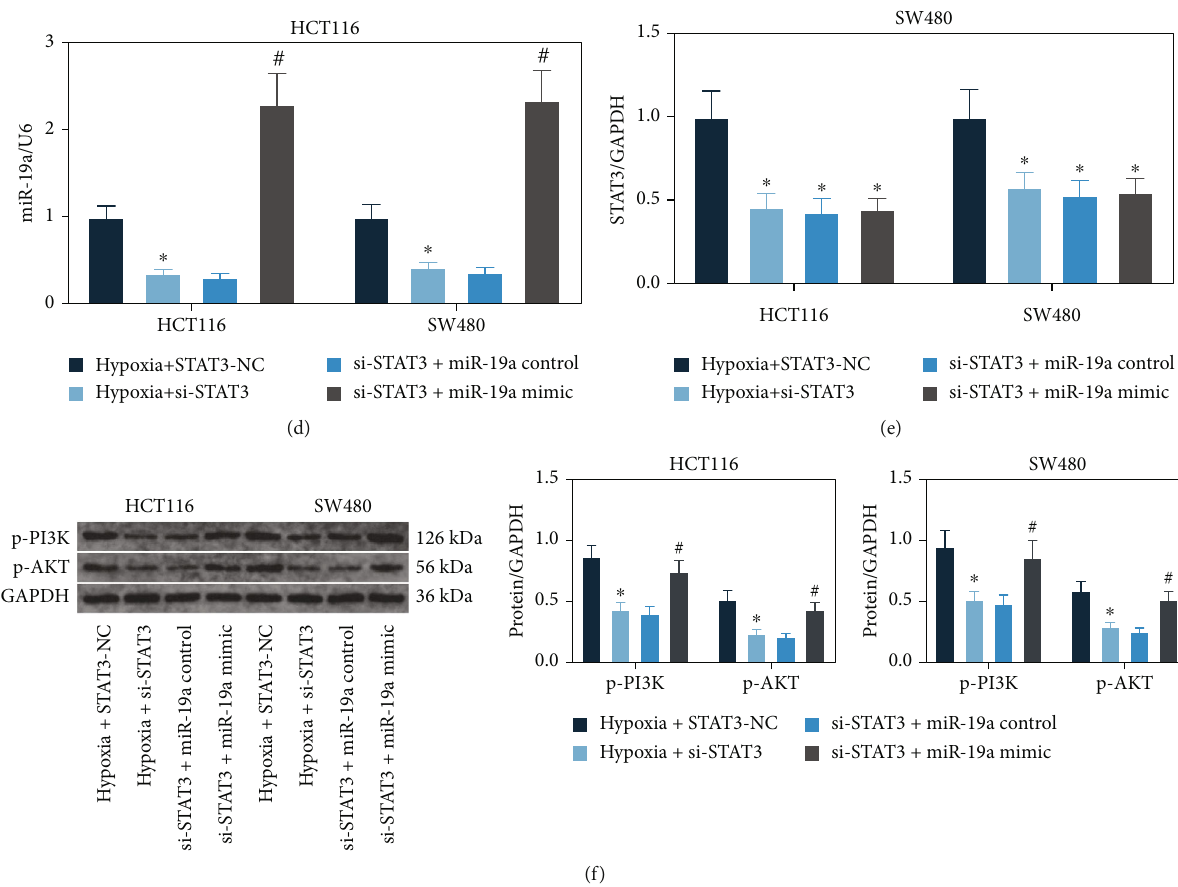
Figure 4: miR-19a mediates the PI3K/AKT signaling pathway in the hypoxia-exposed CRC cells: (a) downstream mRNAs of miR-19a predicted using the StarBase system; (b) transfection e ffi cacy of miR-19a mimic examined using RT-qPCR ( ∗ p < 0 : 05 , two-way ANOVA); (c) activation of PI3K/AKT and Wnt/ β -catenin signaling pathways in HCT116 and SW480 cells after miR-19a mimic transfection examined by western blot analysis ( ∗ p < 0 : 05 , two-way ANOVA); (d, e) expression of miR-19a and STAT3 in HCT116 and SW480 cells after si-STAT3 or si-STAT3+miR-19a mimic transfection examined by RT-qPCR ( ∗ # p < 0 : 05 , two-way ANOVA; ∗ compared to hypoxia +STAT3-NC; # compared to si-STAT3+miR-19a control group); (f) phosphorylation of PI3K and AKT in cells examined by western blot analysis ( ∗ # p < 0 : 05 , two-way ANOVA; ∗ compared to hypoxia+STAT3-NC; # compared to si-STAT3+miR-19a control group). Data were presented as the mean ± SD from three independent